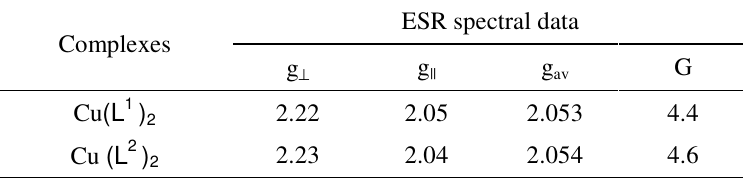
L 1 and H L 2 2